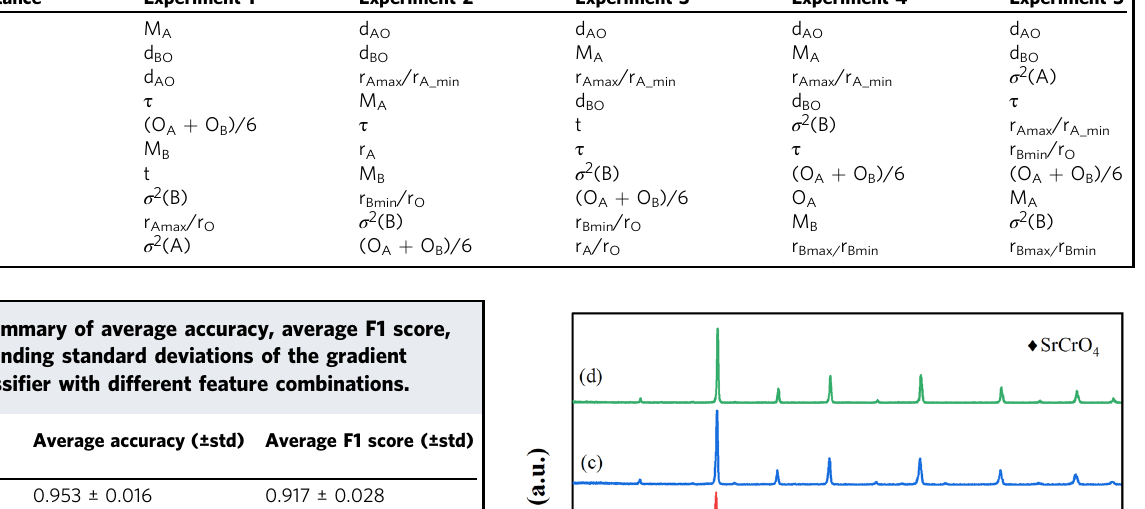
Table 2 Top 10 crucial features given by the gradient boosting classi fi er with 5-fold cross-validation. Feature importance